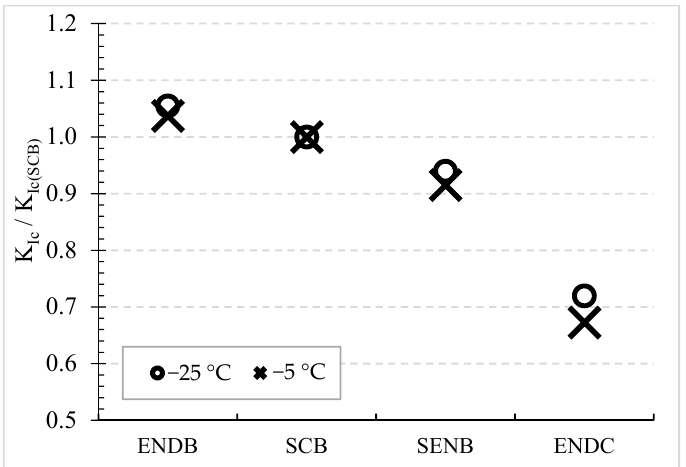
Figure 11. Normalized mode I fracture toughness ratio ( K Ic / K Ic (SCB) ) for the tested samples.